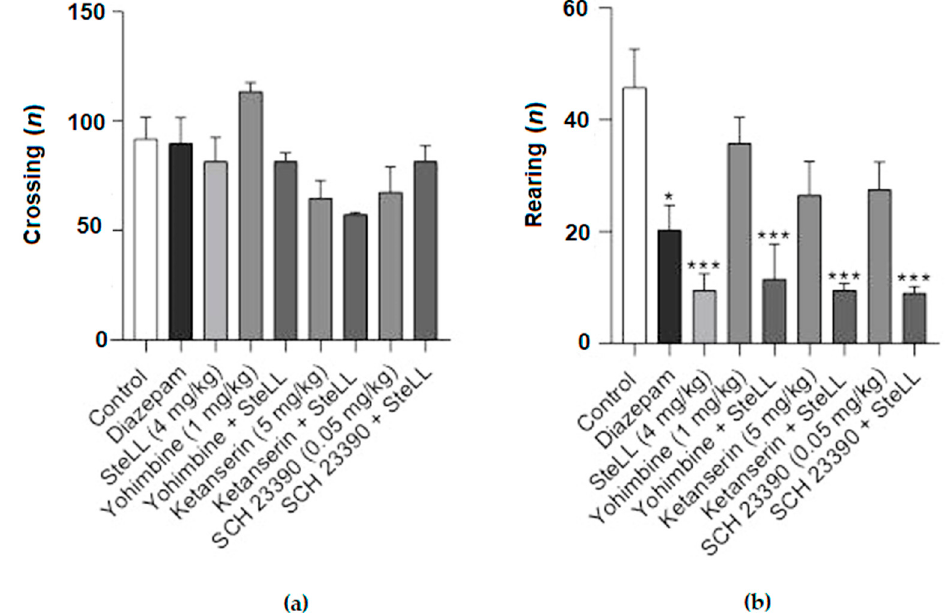
Figure 6. The blockage of the monoaminergic signaling did not alter the rearing responses of SteLL administration (4 mg/kg) on the OFT. The nonselective antagonist of the α 2-adrenoceptor yohimbine 1 mg/kg, the 5-HT2A/2C serotonin receptor antagonist ketanserin 5 mg/kg, and the D1 dopamine receptor antagonist SCH 23390 0.05 mg/kg were evaluated. ( a ) There were no significant changes in the numbers of crossing among the groups. ( b ) SteLL 4 mg/kg decreased the number of rearings compared to the control even in animals pretreated with the antagonists. (*) p < 0.05; (**) p < 0.001; (***) p < 0.0001 compared to control.